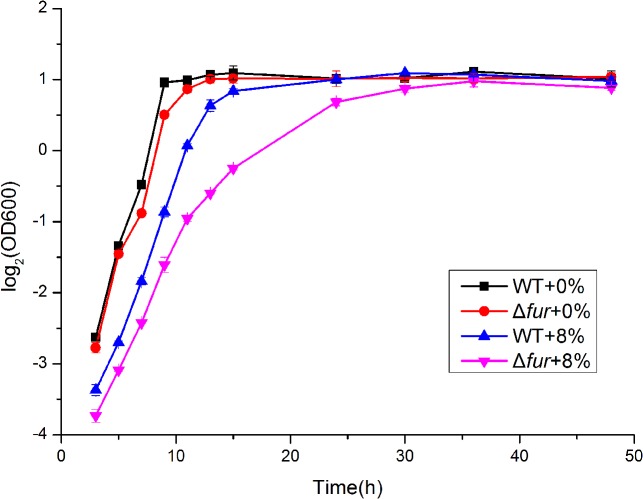
Growth curves of WT and Δfur at different salinities.The WT strain and Δfur strain were cultured in modified alkaline Horikoshi-II medium containing 0% or 8% (w/v) NaCl.